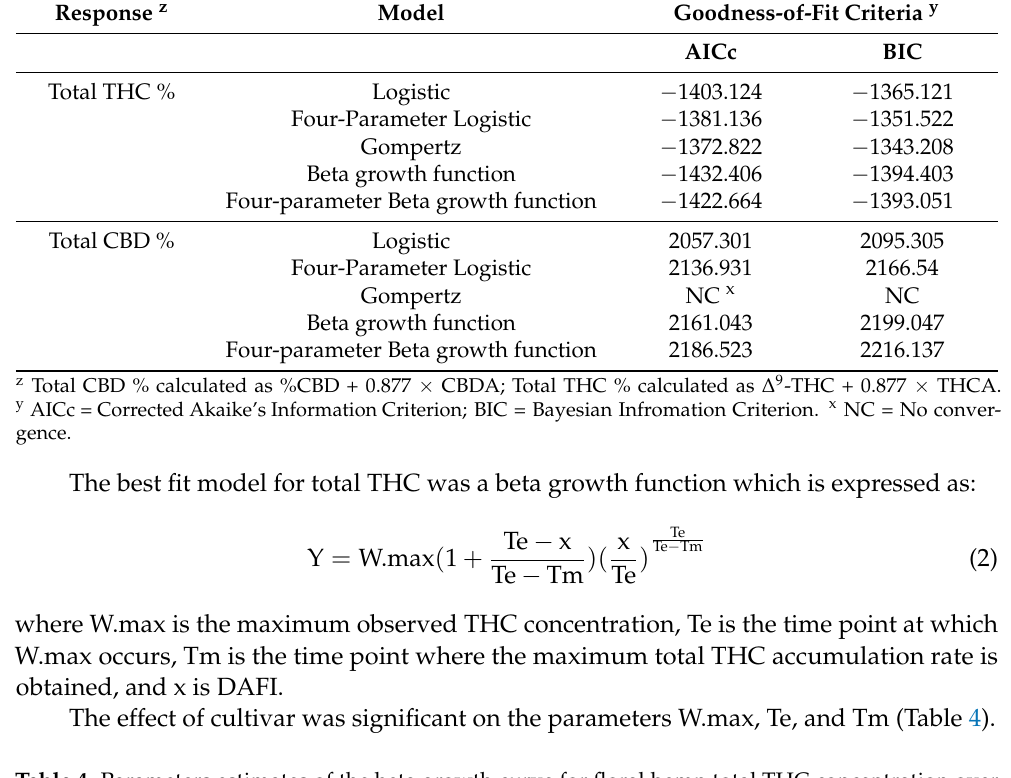
Table 4. Parameters estimates of the beta growth curve for floral hemp total THC concentration over time for the floral hemp cultivars BaOx and Cherry